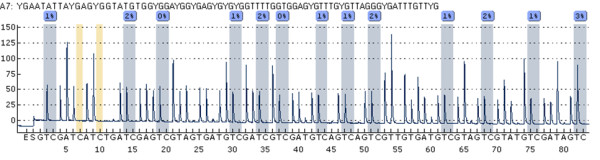
MLH1 region 2 pyrogram. The extended MLH1-2 assay pyrogram showing 13 analyzed sites (sample P27 T0).